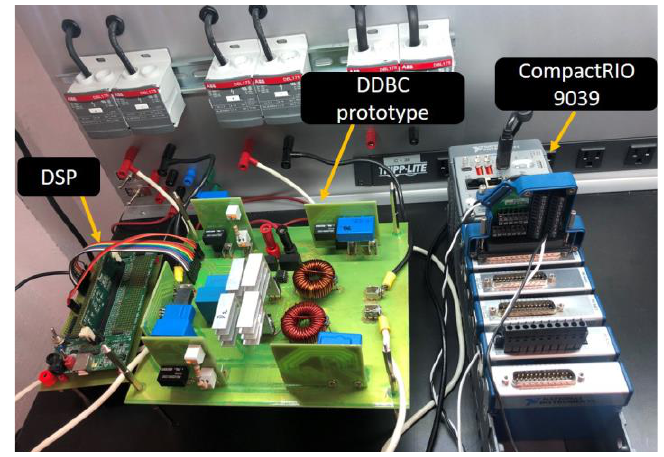
Figure 6. Picture of the implementation of the proposed input current controller.